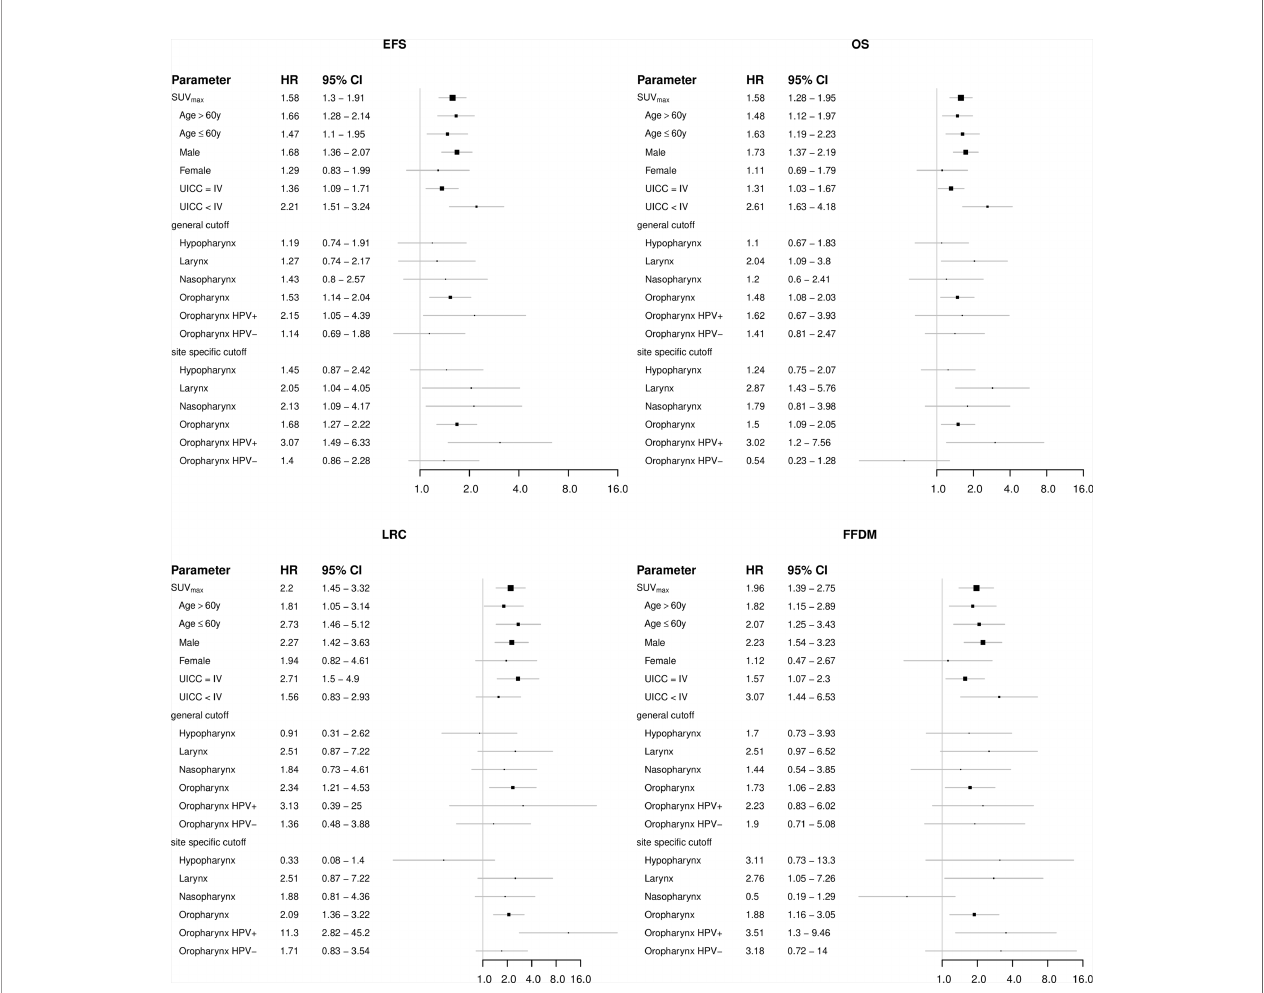
FIGURE 4 | Forest plots showing the prognostic value of the FDG-PET parameter maximum standardized uptake value (SUV max ) in subgroups of patients regarding the clinical endpoints EFS, OS, LRC and